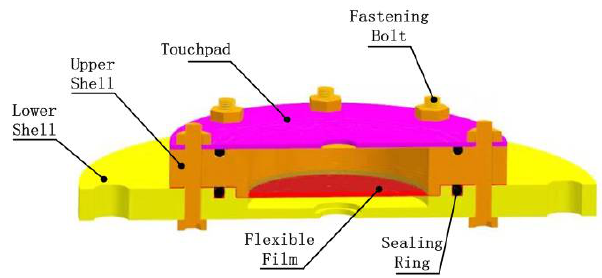
Figure 2. Schematic diagram of the fluid chamber structure.